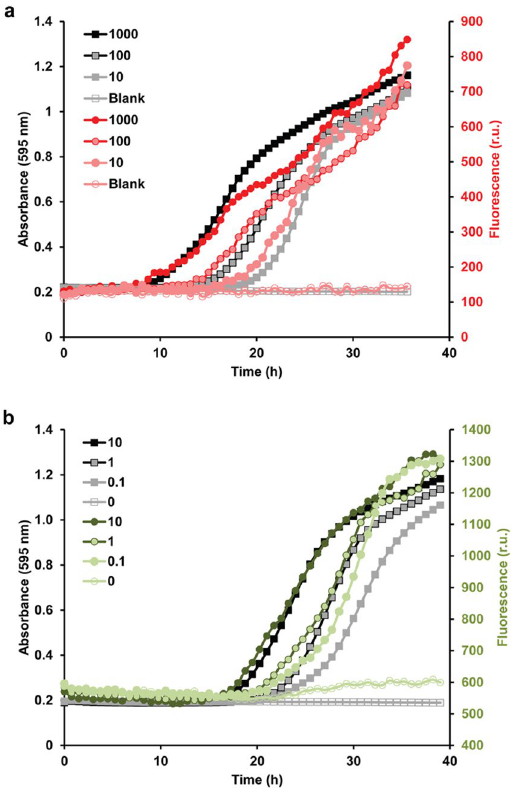
Figure 4. Multiplexing the platform to acquire quantitative growth and fluorescent data. Different conidial concentrations of the H1-RFP ( a ) and the gamma-actin-GFP ( b ) strains were inoculated on solid media containing ammonium as the sole nitrogen source. Growth was monitored by measuring absorbance at 595 nm (grey and black symbols). In parallel, fluorescence was detected as described in the Methods section (red symbols: fluorescence in the red channel; green symbols: fluorescence in the green